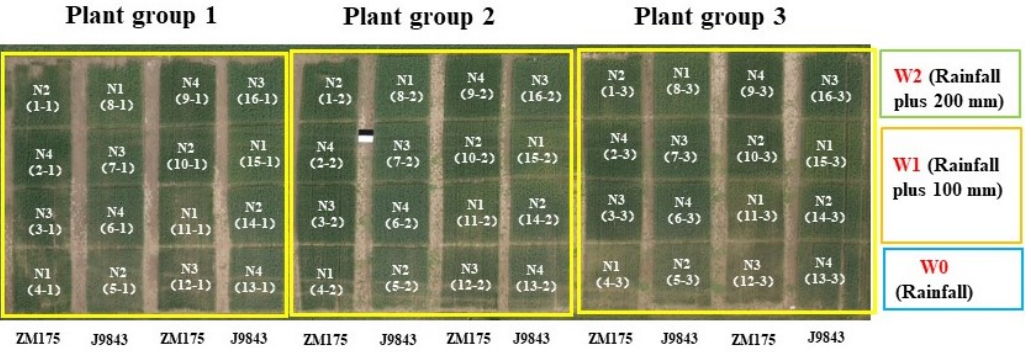
Figure 2. Experimental design. ZM175: winter-wheat variety Zhongmai 175; J9843: winter-wheat variety Jingmai 9843. N1, N2, N3, and N4 represent nitrogen treatments of 0, 195, 390, and 780 kg/ha, respectively.